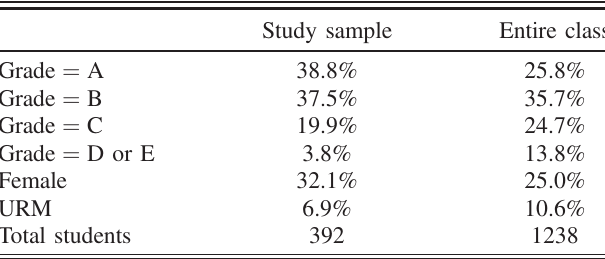
TABLE III. Comparison of the study sample to the entire